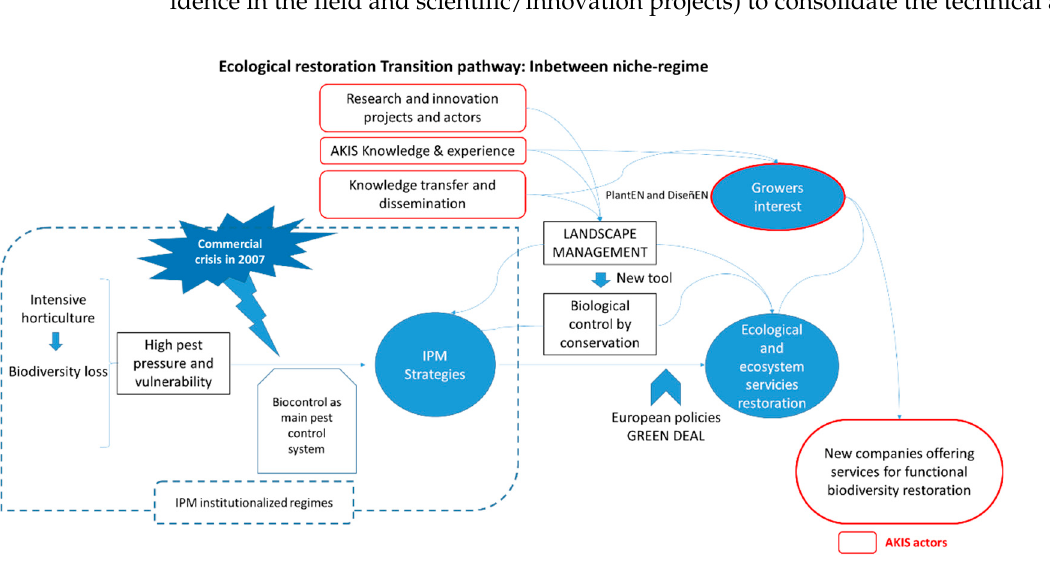
Figure 4. AKIS and ecological restoration transition pathways (authors’ elaboration).